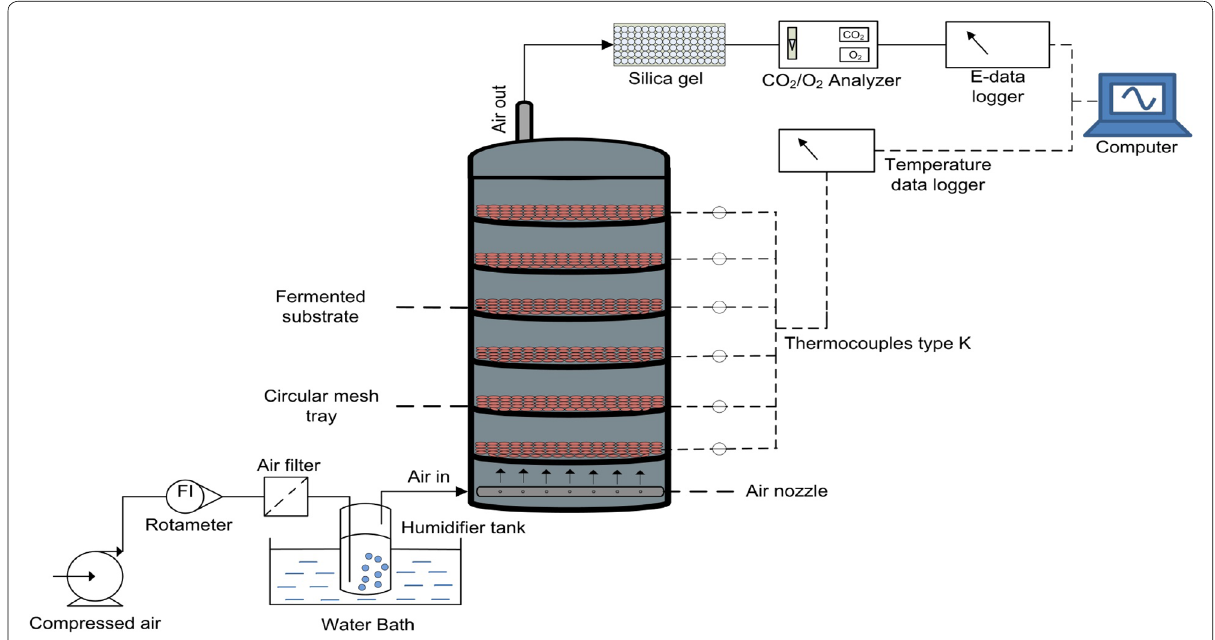
Fig. 2 A schematic diagram of the experimental set-up of the multi-stacked circular tray